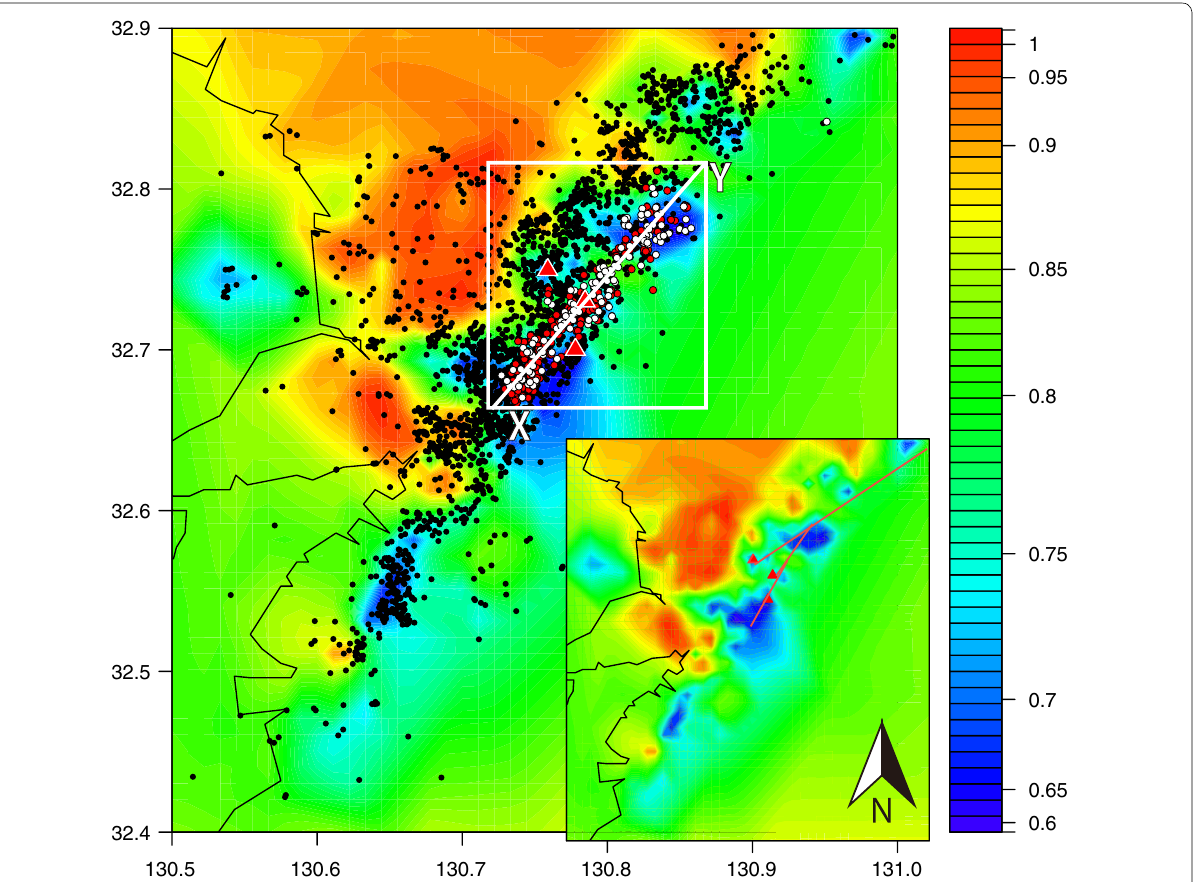
Fig. 11 The horizontal changes in b -value. The white and red dots represent the epicenters of the foreshocks before and after the M6.4 event, respectively, and the black dots represent the epicenters of the aftershocks. The red triangles indicate the epicenters of the M6.4, M6.5, and M7.3 earthquakes from south to north. The red segments indicate simplified traces of the Hinagu Fault and the Futagawa Fault from south to north (see Table 3 for the fault parameters). The inset panel shows only the b -value